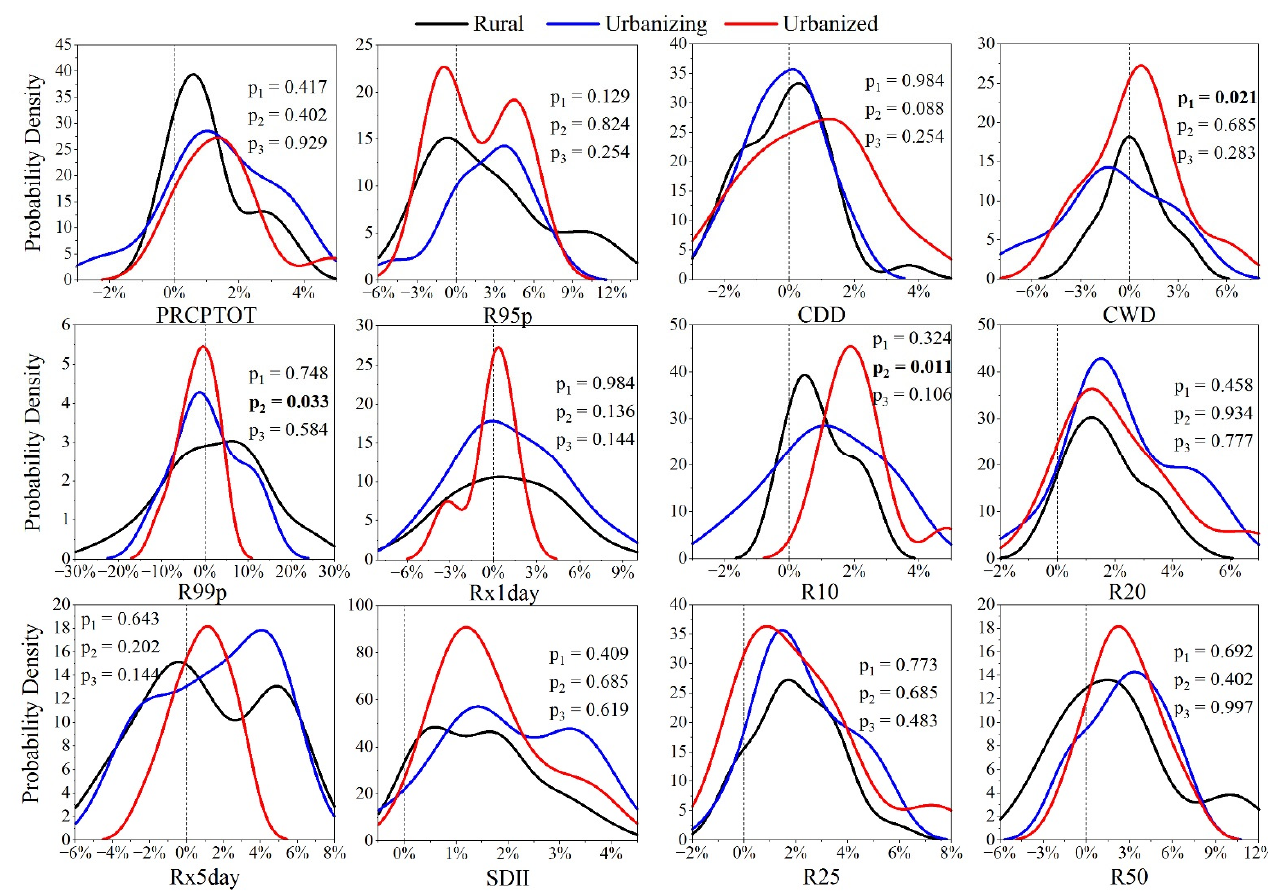
Figure 7. Probability density functions of normalized trends in precipitation extremes for rural, urbanizing, and urbanized areas during 1961–2017. The p values indicate whether the differences in the two distributions for precipitation extremes are significant or not based on the two-sample Kolmogorov–Smirnov test. The p 1 value is estimated based on the rural and urbanizing series, p 2 on the rural and urbanized series, and p 3 on the urbanizing and urbanized series.